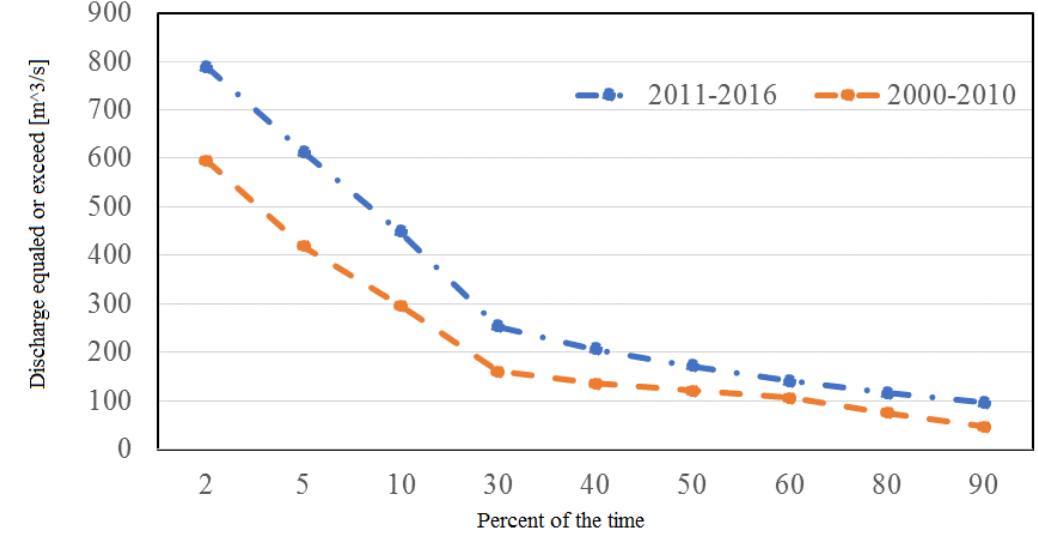
Figure 7. Flow characteristics for the Garissa gauging station showing discharge equaled or exceeded and